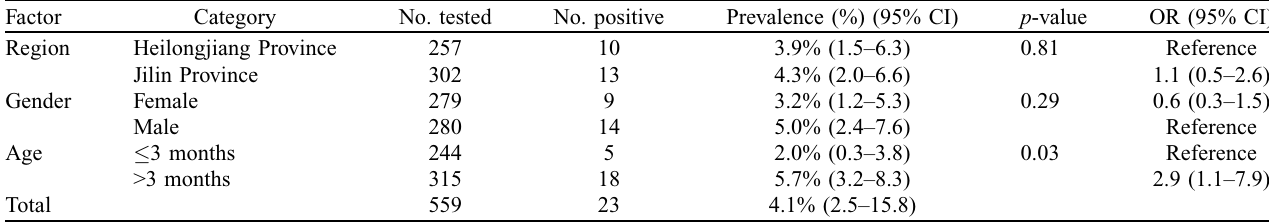
Table 1. Prevalence of Enterocytozoon bieneusi in minks in Jilin and Heilongjiang provinces, China. Factor Category No.